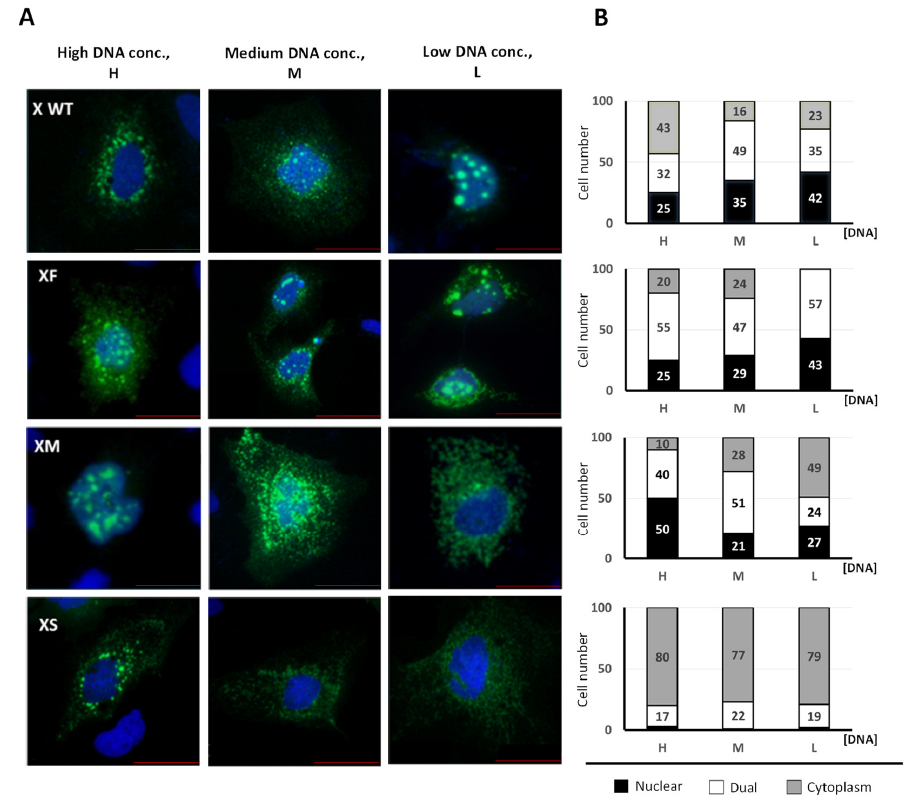
Figure 2. Subcellular localization of HBx canonical, and individual HBx isoforms in cultured hepatocarcinoma cells. ( A ) Fluorescence of the GFP-tagged HBx proteins in hepatoma cells transfected with high (H, left), medium (M, middle) or low (L, right) amounts of the plasmid DNA constructs [27,86,90]. Representative images of cells transfected with X WT (HBx WT), XF (HBx full-length), XM (HBx medium-length), XS (HBx short-length), each of them fused to the GFP protein are shown. Bar for scale of 50 µm. ( B ) 100 positive cells for the expression of GFP of WT or mutant HBx proteins were analyzed. Cells were all transfected with three different amounts of DNA, and after 24 h, coverslips were processed for fluorescence microscopy. Expression of HBx-GFP isoform proteins was associated with either the cytoplasm, nucleus, or nucleocytoplasmic (dual) compartments with respect to DAPI-positive nuclear staining.